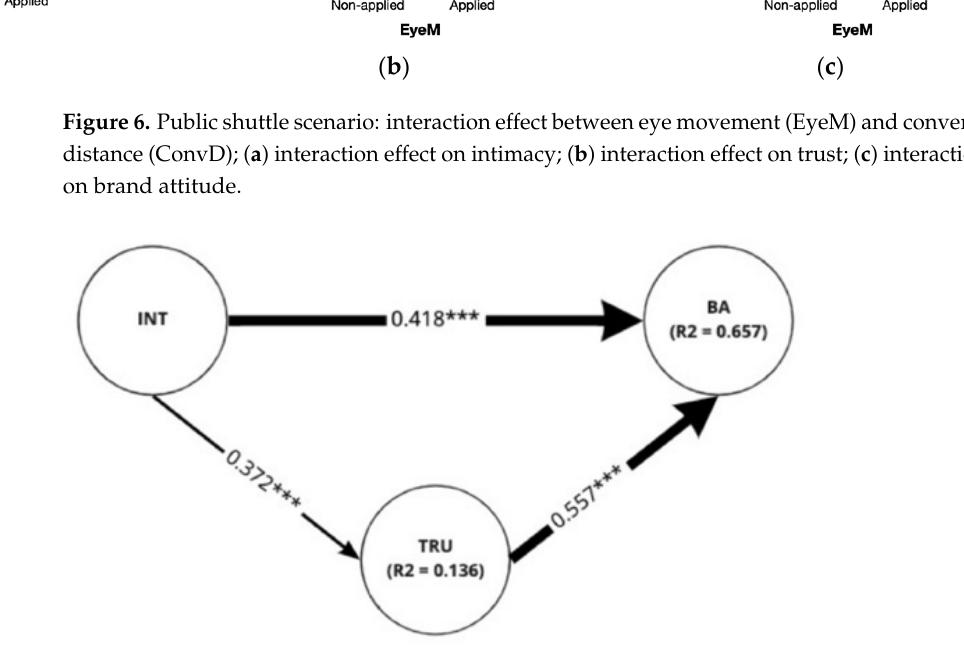
Figure 7. Full sample: Results of analysis on the structural model for the full sample (N = 45). * R 2 values indicated in the figures are adjusted values of R 2 . *** p < 0.001.